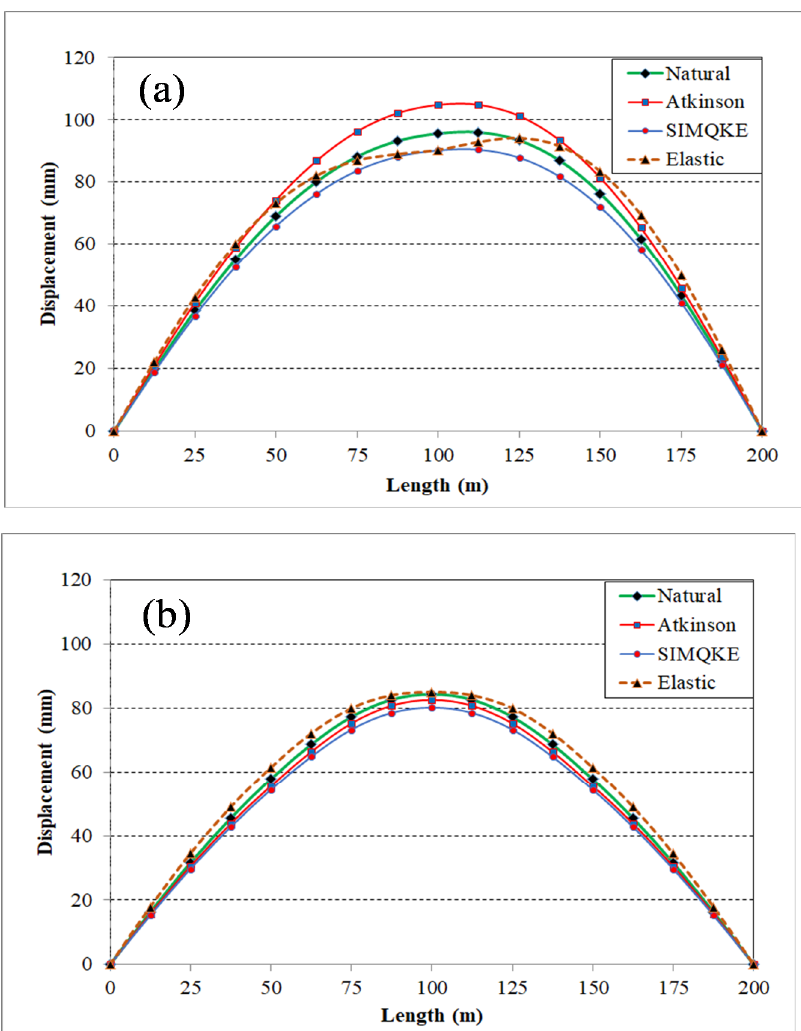
Figure 10. Comparison of displacement envelopes obtained using different record types for ( a ) irregular bridge, and ( b ) regular bridge.